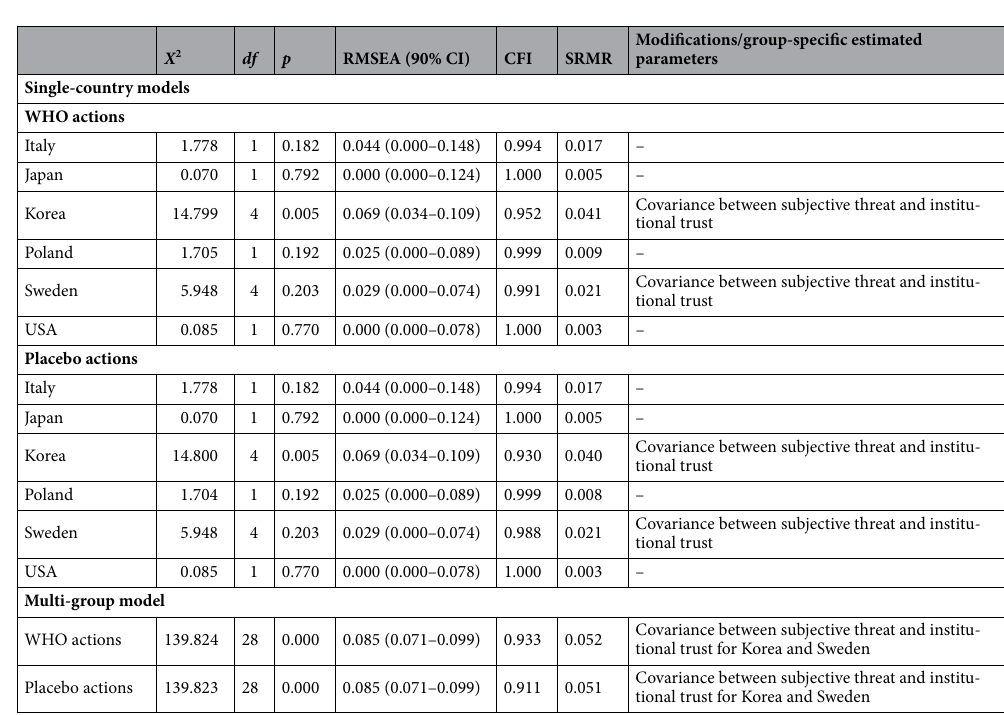
Table 2. Fit indices. Total sample: N = 3346; Italy: N = 405, Japan: N = 190, Republic of Korea: N = 551, Poland: N = 1092, Sweden: N = 587, USA: N =